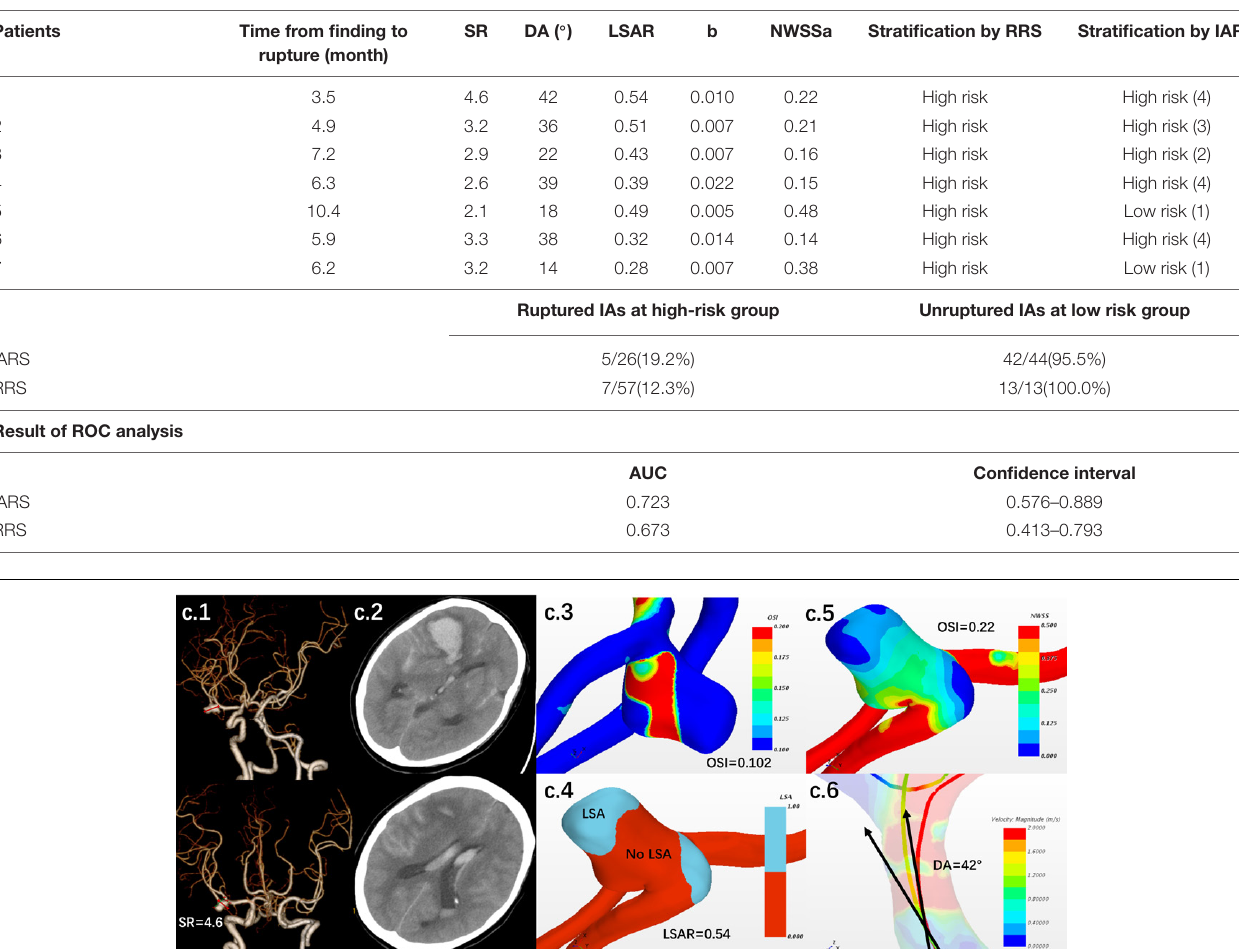
TABLE 5 | Hemodynamic and morphological characteristics of rupture IAs.